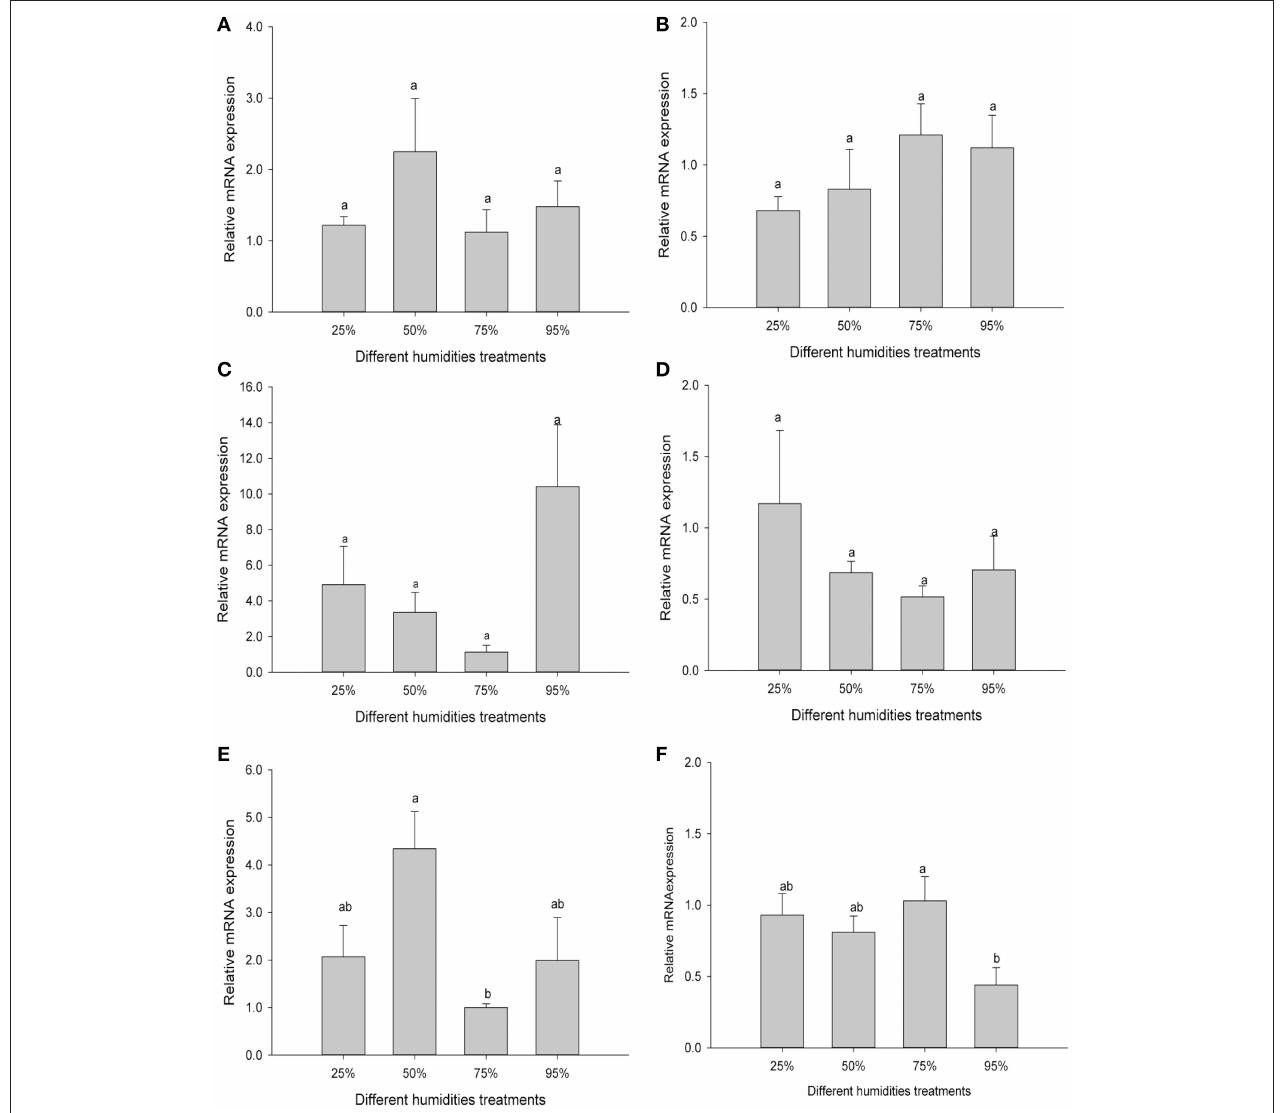
FIGURE 7 | Relative expression levels of Cs Drip1 gene in the Chilo suppressalis under humidity treatments. (A) The third instar larvae treated by 25, 50, 75, and 95% for 12h, respectively. (B) The fifth instar larvae treated by 25, 50, 75, and 95% for 24h, respectively. (C) The female pupae treated by 25, 50, 75, and 95% for 24h, respectively. (D) The male pupae treated by 25, 50, 75, and 95% for 24h, respectively. (E) The female adults treated by 25, 50, 75, and 95% for 24h, respectively. (F) The male adults treated by 25, 50, 75, and 95% for 24h, respectively. Values are denoted as the mean ± SE. Significant differences are indicated as P <